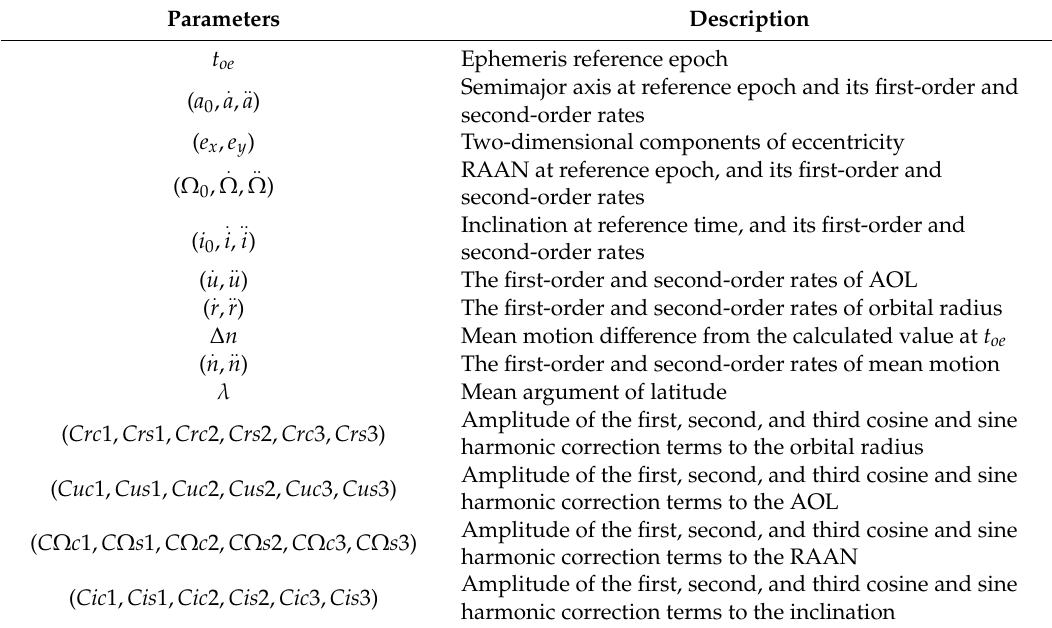
Table 1. Parameters involved in the proposed algorithm. RAAN, right ascension of the ascending node. Parameters